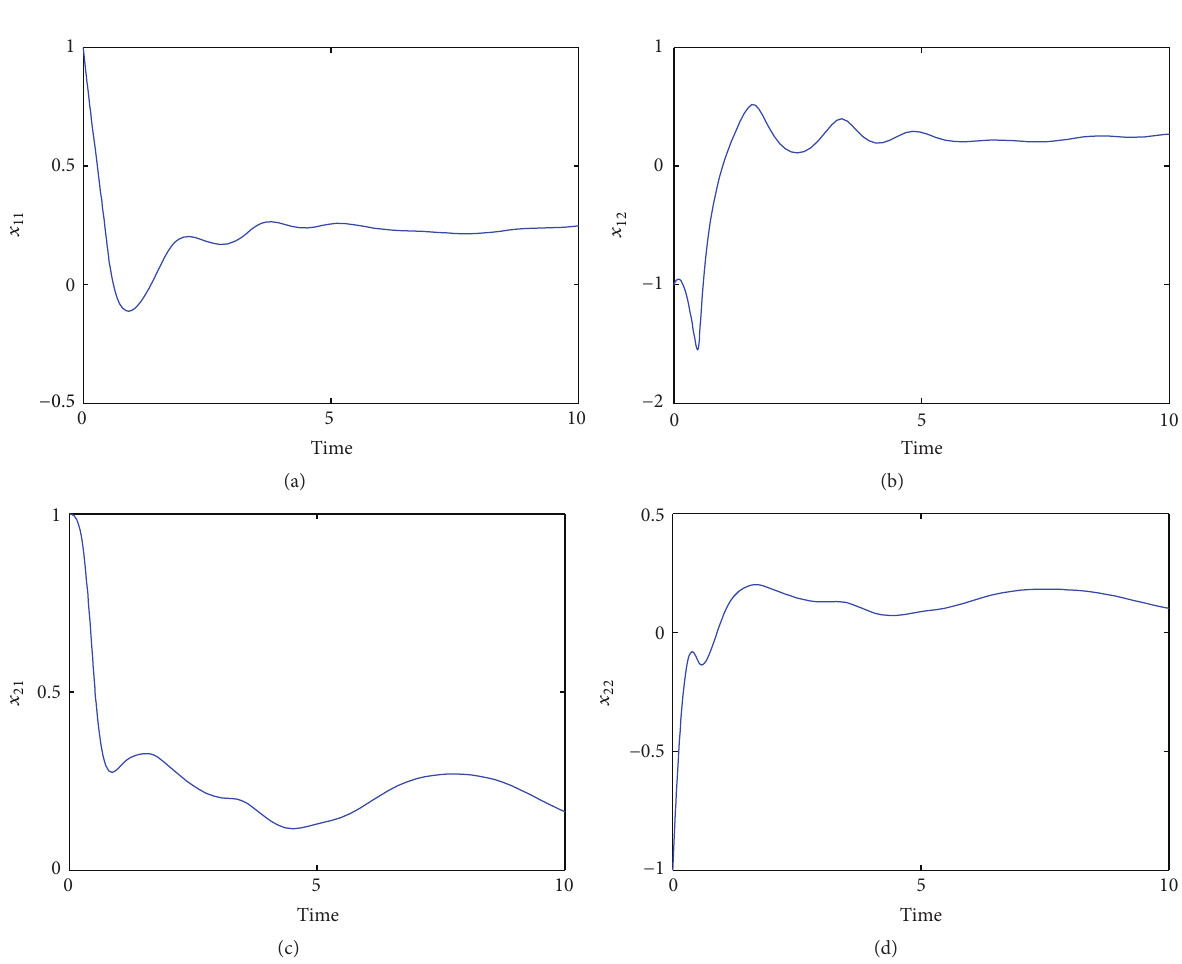
Figure 1: Simulation results of the system states with 𝛽 ∗ 11 = 0.8 , 𝛽 ∗ 12 = 1 , 𝛽 ∗ 21 = 1.2 , and 𝛽 ∗ 22 = 1.4